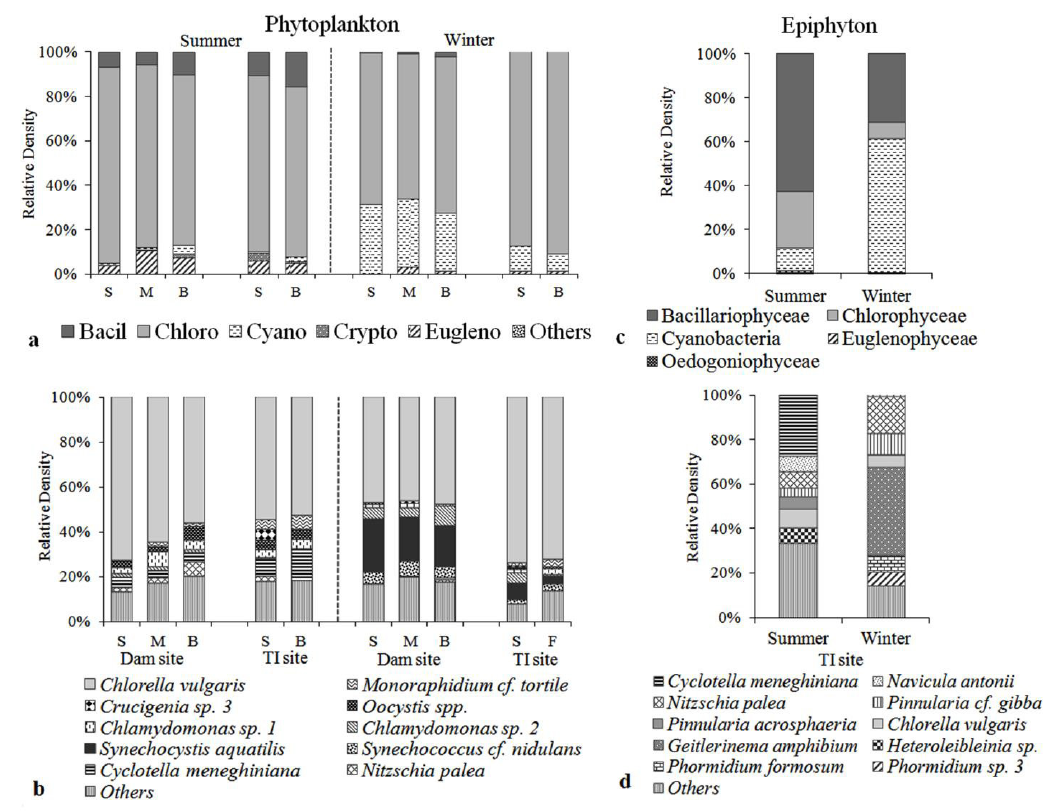
Figure 4. Phytoplankton ( a, b ) and epiphyton ( c, d ) classes density and descriptors species in an urban hypereutrophic reservoir during the study period (S: subsurface, M: middle, B: